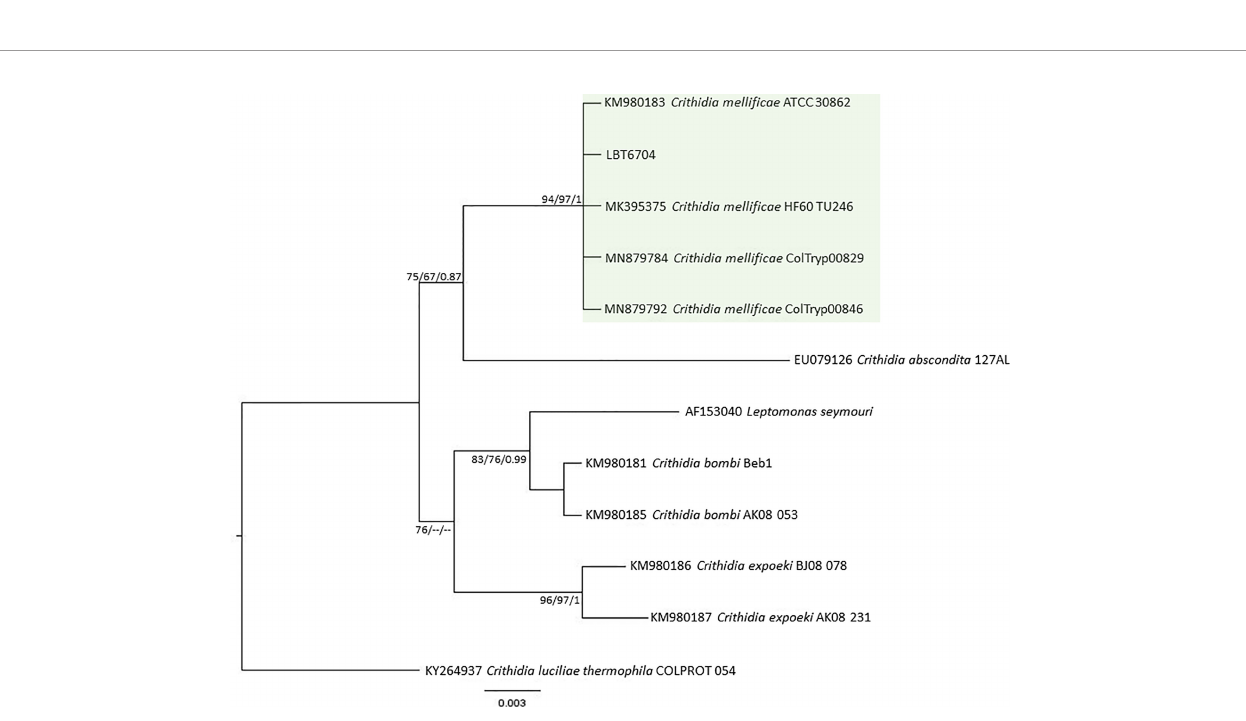
FIGURE 4 | Crithidia melli fi cae phylogenetic tree based on 528 base pairs SSU rDNA fragment length from dog blood clot. The tree was inferred using transitional3 equal frequencies plus gamma distribution (TIM3e+G) and symmetrical plus gamma distribution (SYM+G) models for ML and BI, respectively. The numbers at nodes correspond to ML (ultrabootstrap and SH-aLRT) and BI (posterior probability). The scale bar shows the number of nucleotide substitutions per site. The green square represents the clade formed by LBT6704 with other C. melli fi ace sequences from insects and mammals.